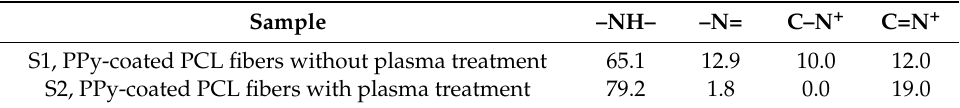
Table 3. The percentage of different bonds at N 1 s spectrum for PPy-coated PCL without and with plasma treatment shows.